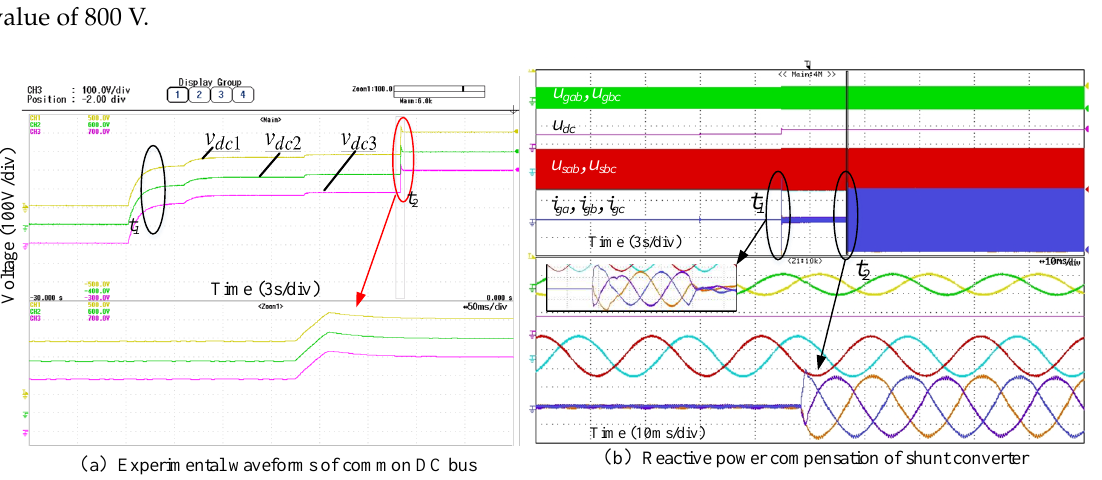
Figure 22. Experimental results of the shunt converters: ( a ) Experimental waveforms of the common DC bus; ( b ) Reactive power compensation of the shunt